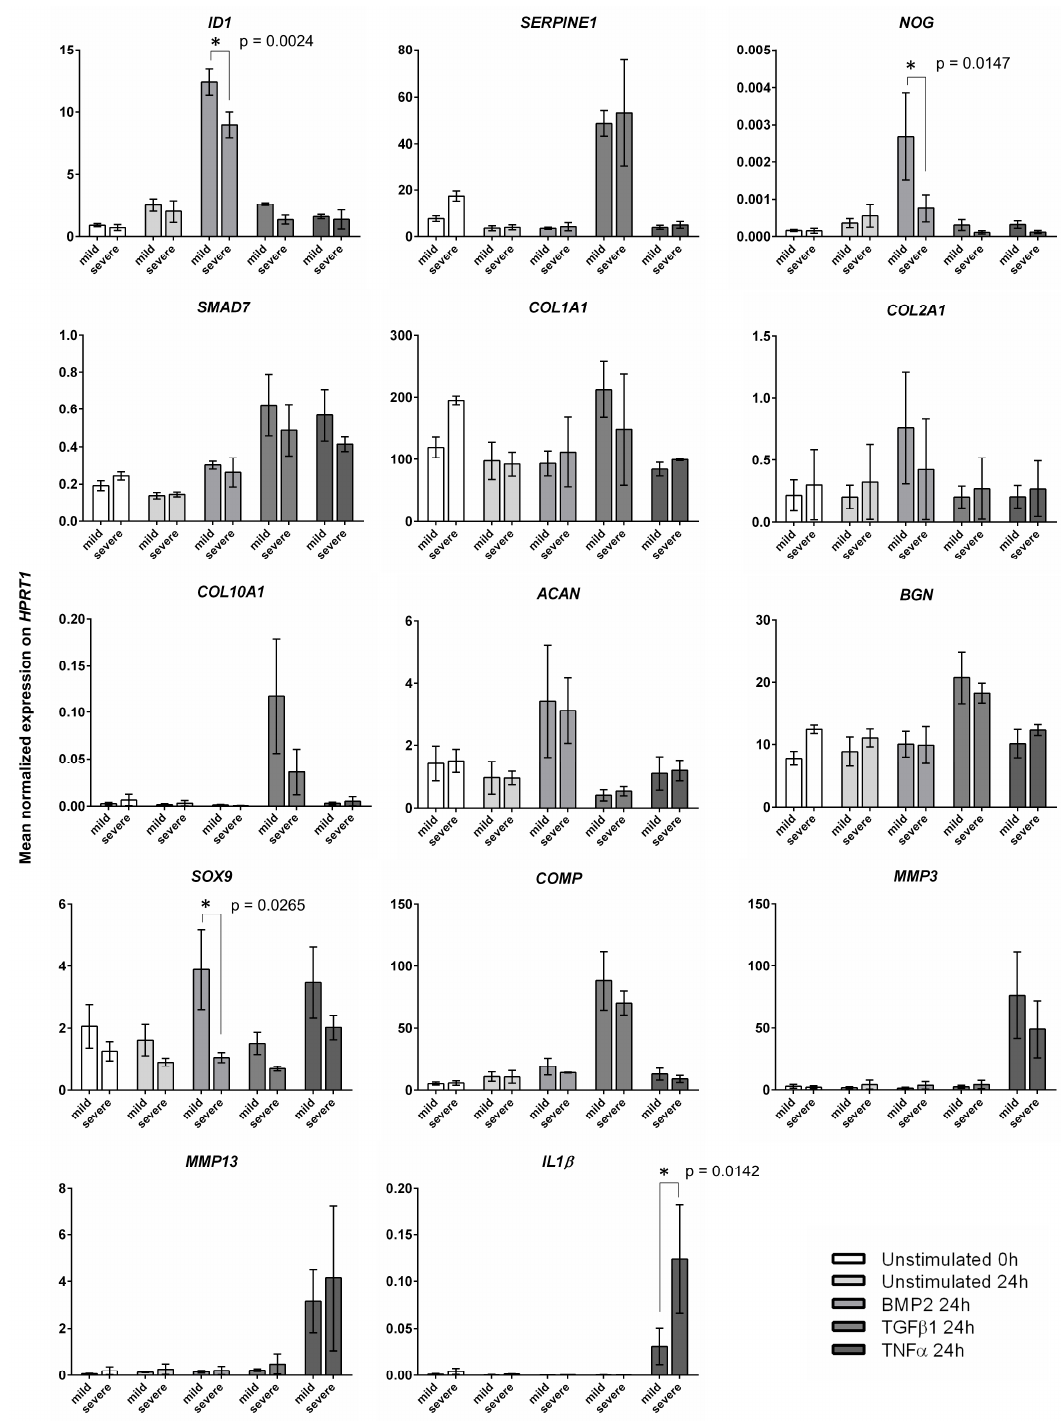
Figure 5. Mean normalized expression of bone morphogenetic protein 2 (BMP2)-, transforming growth factor β 1 (TGF β 1)-, and tumor necrosis factor α (TNF α )-stimulated cells after 24 h and unstimulated cells at the starting point of 0 h and after 24 h (error bars SEM). * p <